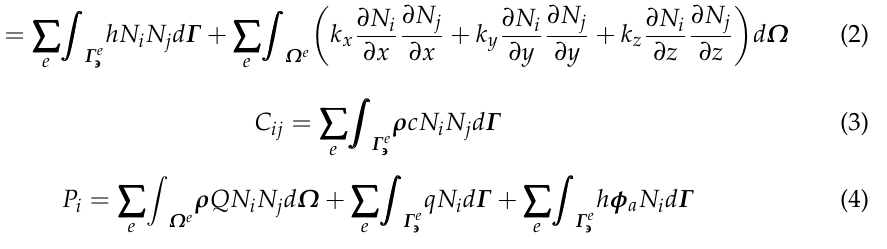
Table 3. Parameters of sedimentary gravel materials.